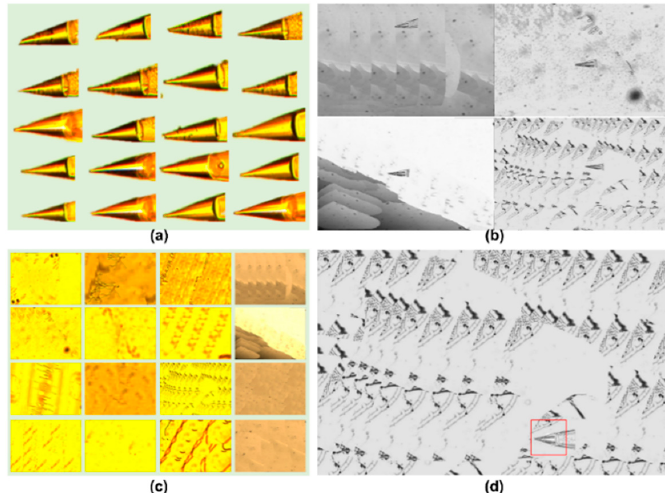
Figure 5. ( a ): The real ISME images; ( b ): the background images under different light and noise conditions ( c ): virtual samples; ( d ): the generated test samples.